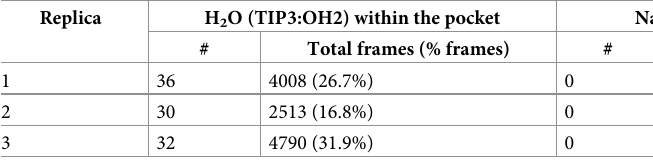
compared to the crystal structure (4ZUD), and the predicted affinity to the experimentally derived 95% confidence interval of the affinity, as expressed in -Log(Molar), of 7.985 to 8.595 [21]. None of the docking programs accurately predicted the affinity, but Autodock 4.2 pro- vided the nearest estimate. AutoDock Vina predicted a single pose somewhat similar to the crystal structure (Fig 4B); however, the predicted affinity was significantly worse than Auto- Dock 4.2. MOE was run three times, with each iteration containing a change to the system. The first run (grey in Fig 4C) was run identical to the AutoDock runs and produced a single Table 2. Solvent in and around the inactive human apo-AT 1 R.